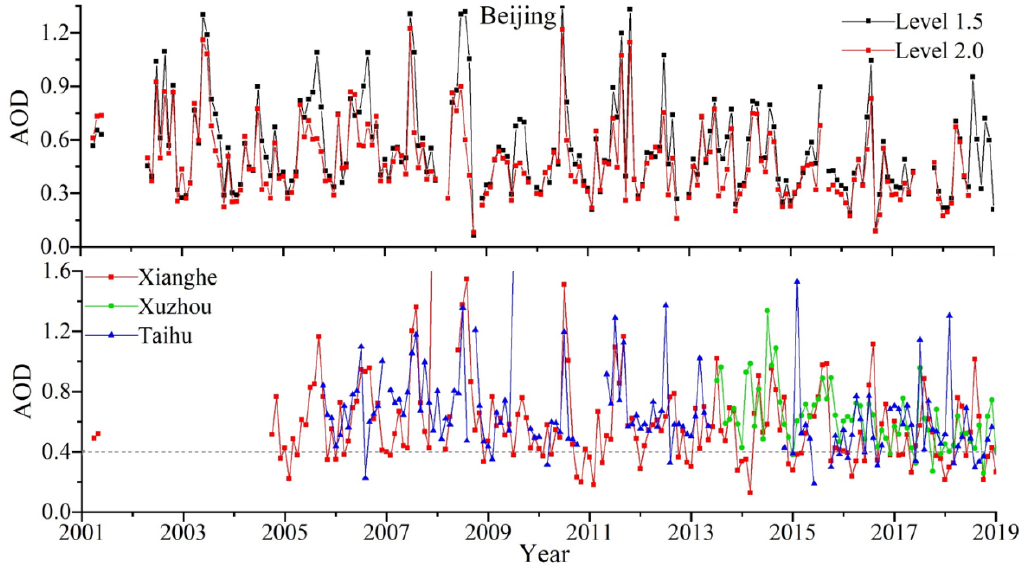
Figure 4. Temporal variations of monthly AERONET AOD.